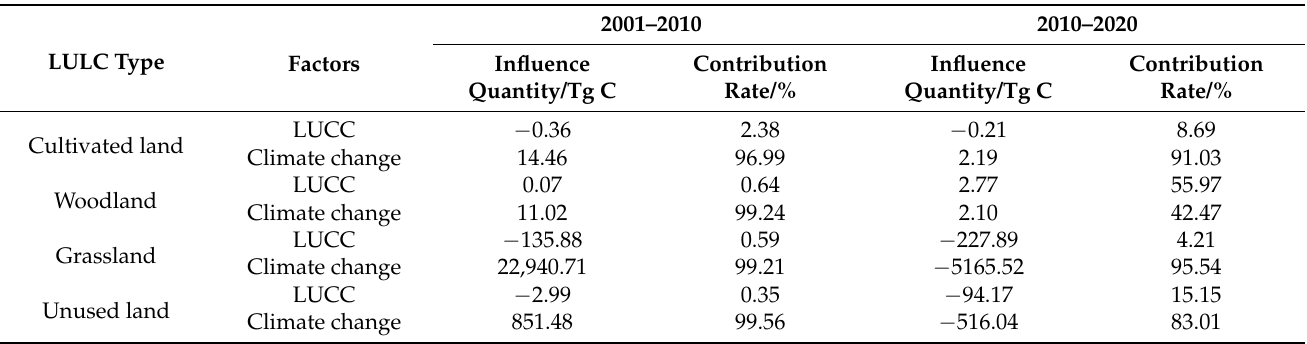
Table 3. Influence and contribution of different land use/land cover (LULC) types to the total NPP from 2001 to